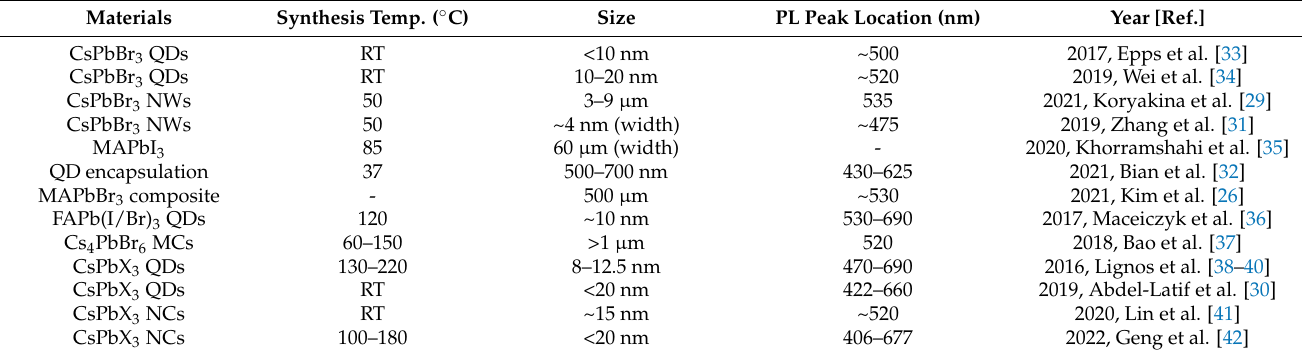
Table 1. Microfluidic synthesis of nanostructured halide